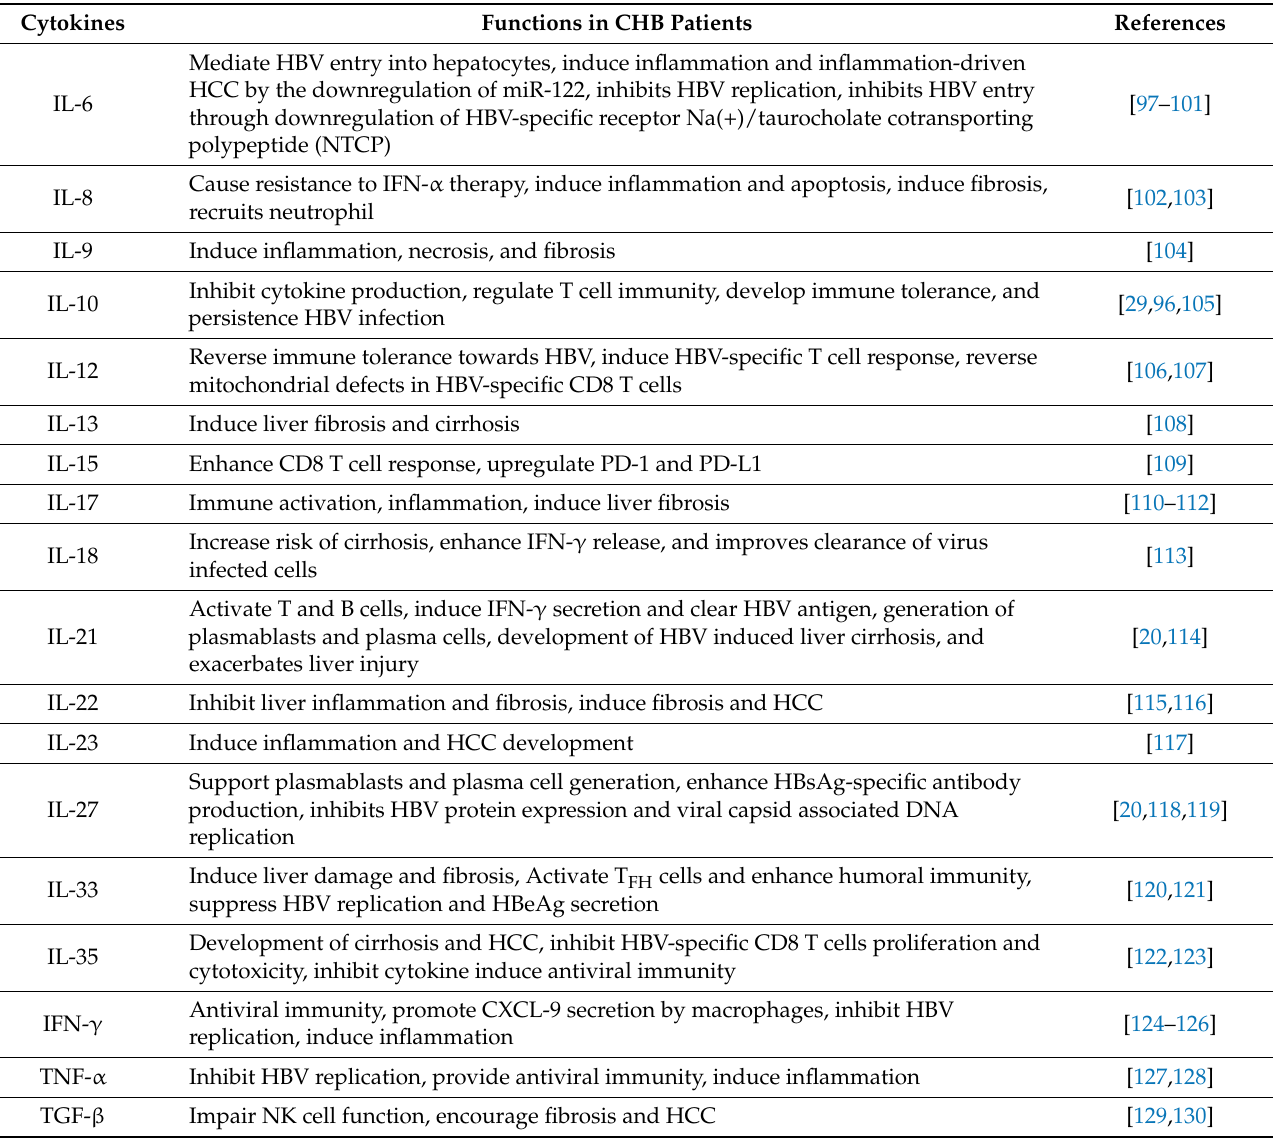
Table 1. Role of inflammatory mediators in